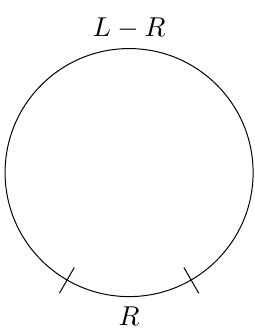
, with n ∈ N . For Dirichlet L and m = πn , with n ∈ N . Both solutions L − R R and m (cid:29) r − 1 , c c